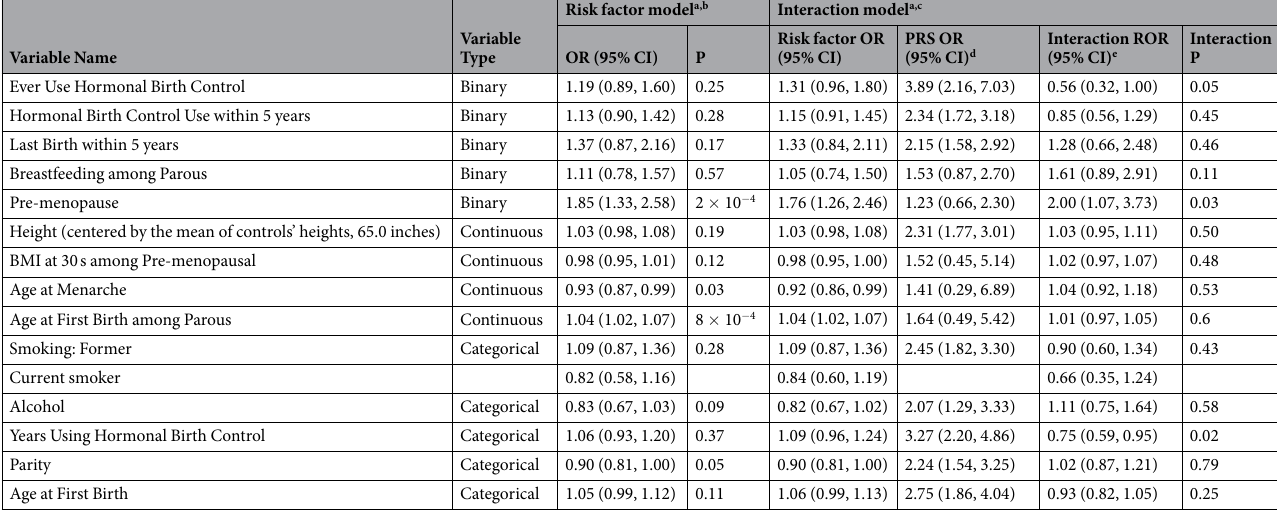
Table 3. Results of conditional logistic regression for either ductal carcinoma in situ or invasive breast cancer in non-Hispanic white families. a All models have birth order as a covariate. In addition, parity and age at first birth were adjusted for in breastfeeding models; alcohol and smoking were mutually adjusted for each other; age at menarche was adjusted for in models for years using birth control; and age at first birth was adjusted for in parity models. b We assumed a linear trend in the risk factor effect in the risk-factor-only models for all categorical variables except for smoking. c For all categorial variables, when testing for interaction effects, exposure was treated as categorical variable but a linear trend in the intraction term was assumed for all but the smoking variable. However, for the simplicity of presentation the risk-factor risk parameters shown above were based on a linear trend. d OR is per unit change in PRS (Shi et al . 2017). e The interaction parameter is the ratio of the PRS effect in the exposed category divided by the PRS effect in the unexposed category or those whose value of the risk factor is one unit